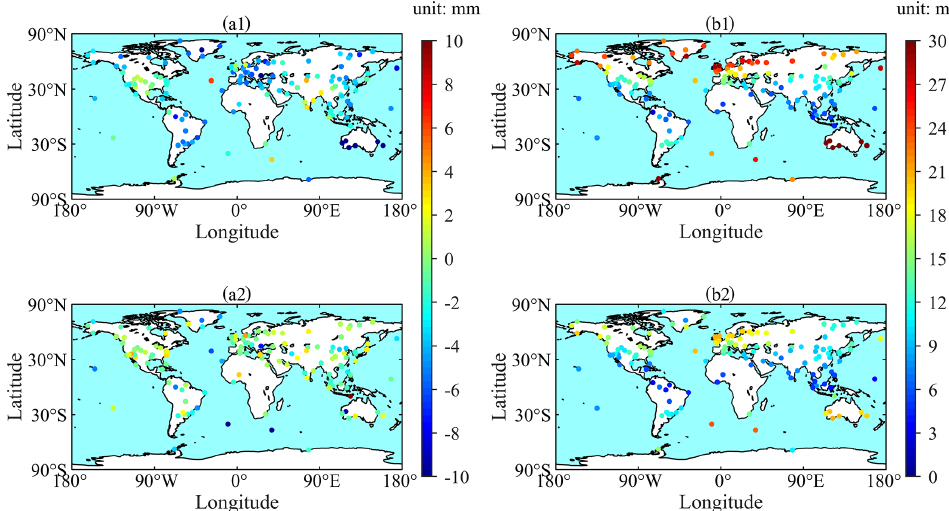
Figure 5. Bias (a1) and RMSE (b1) of ZHD-GPT3 and bias (a2) and RMSE (b2) of ZHD-GZHD at each of the 137 radiosonde stations during the 20-year period of 2000–2019 (reference: ZHD-RS).